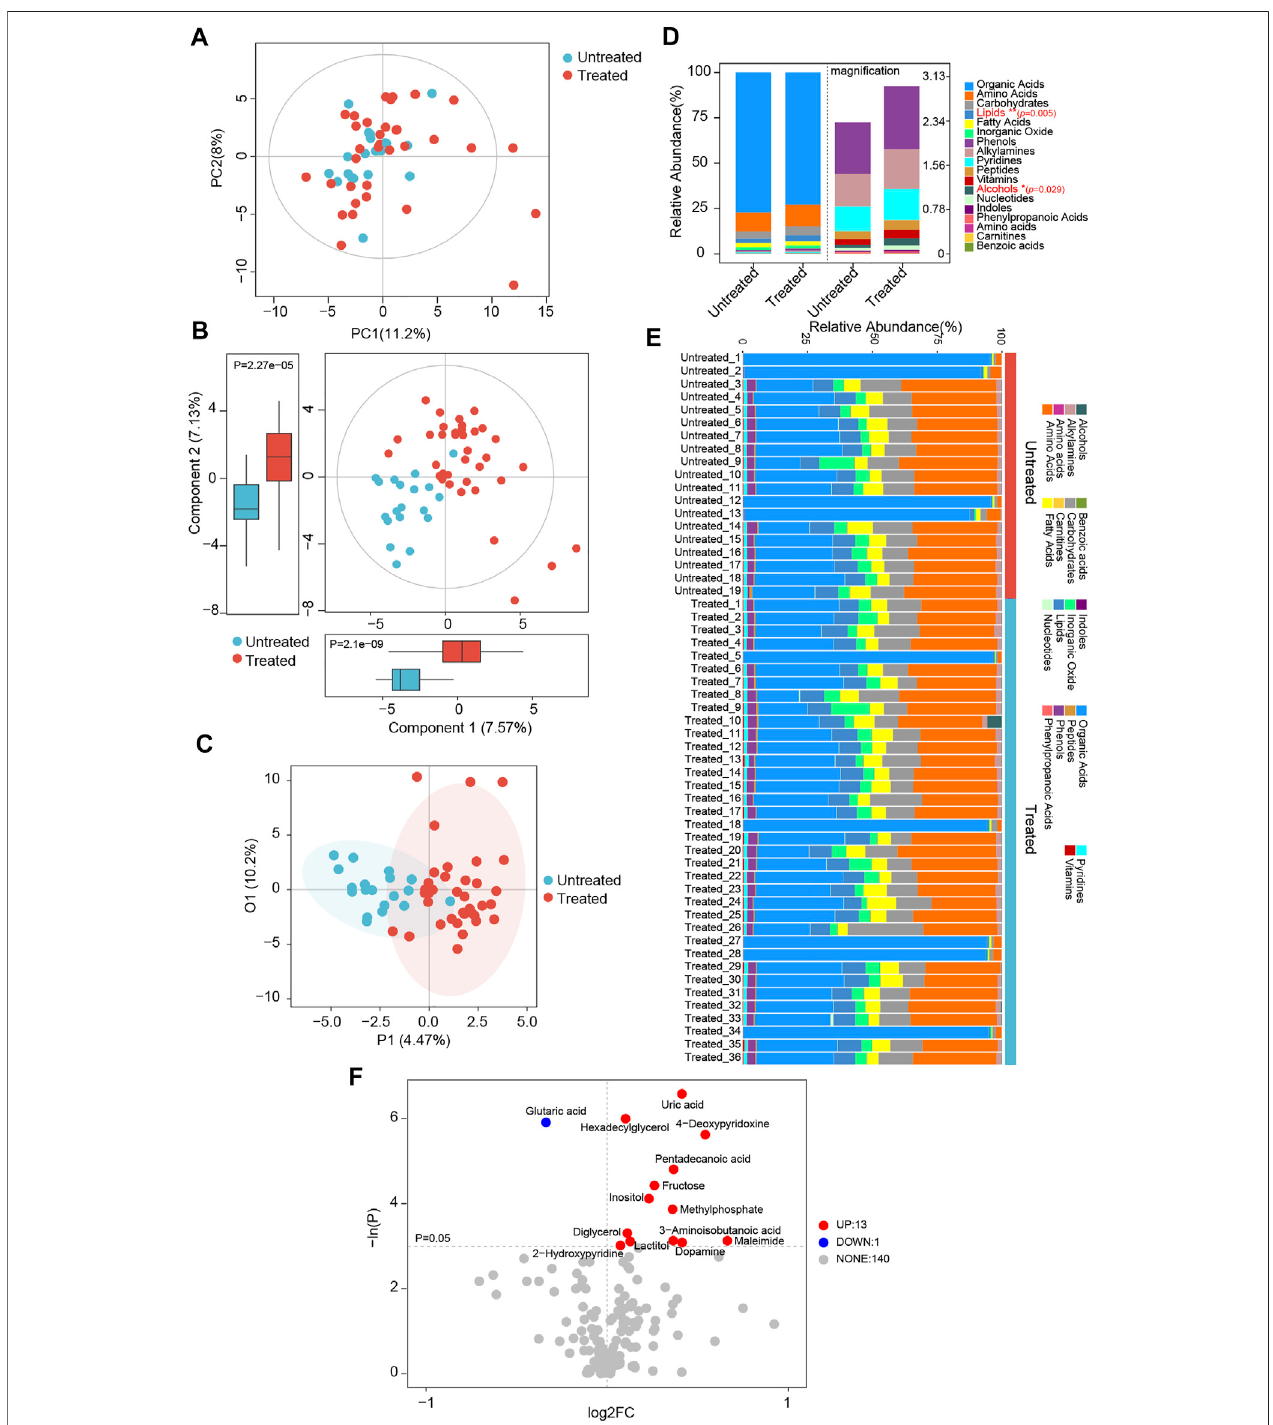
FIGURE5| GlobalpatternsfortheserummetabolomeinACEI/ARB-treatedHTNpatients. (A) PCAplotsdepictingthemetabolicpro fi lesandfeaturesaccordingto untargetedGC-TOF/MSdataofserum samplesfromuntreatedand treated hypertensive groups. PC1,principalcomponent 1; PC2,principal component 2. (B) Scatter plots of PLS-DA identifying the metabolic discrimination and separation between groups. p = 2.1e − 09 and 2.27e − 05 between untreated and treated groups were obtainedatComponent1andComponent2,respectively. (C) OPLS-DAwithscatterplotsshowsthemetabolicdiscriminationandseparationbetweengroups. (D) Relative abundance and percentage of serum metabolites and class composition detected in untreated and treated HTN patients. * p < 0.05, ** p < 0.01. (E) Relative abundanceofannotatedmetaboliteclassinserumsamplesofeachindividualfromuntreated andtreatedgroups. (F) Volcanoplotsshowsigni fi cantalterationsofserum metabolites between groups. Metabolites at p < 0.05 were considered to be signi fi cantly distinct. Up, the number of signi fi cantly elevated serum metabolites in the treated group as compared with untreated HTN patients; Down, the number of dramatically decreased metabolites in treated group; None, the number of metabolites not signi fi cantly altered between groups. Each metabolite is labeled with the corresponding annotation.